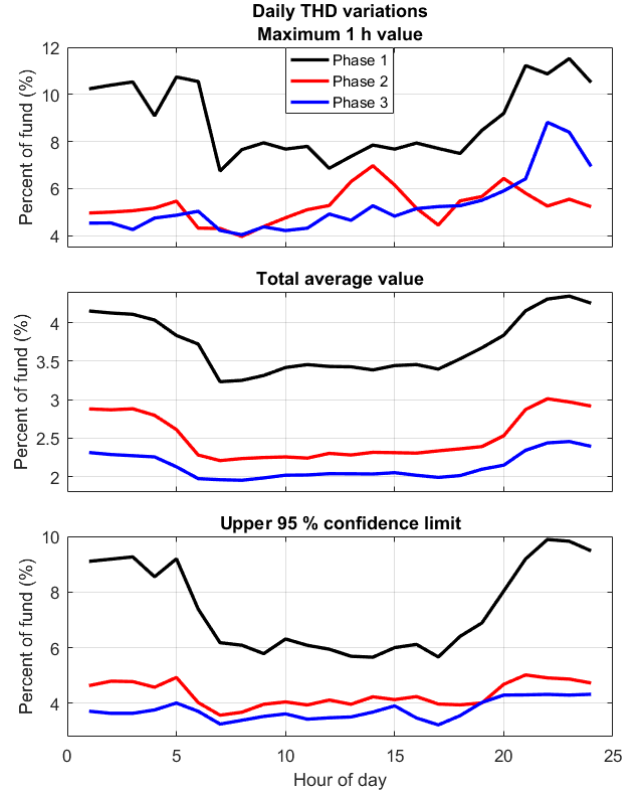
Figure 3. The 1 h maximum THD value, total average THD value and upper 95% confidence limit for every hour during the day for 29 weeks of continuous islanded operation. The black, red and blue color represents the three phases. Note the difference in vertical scale for each plot.